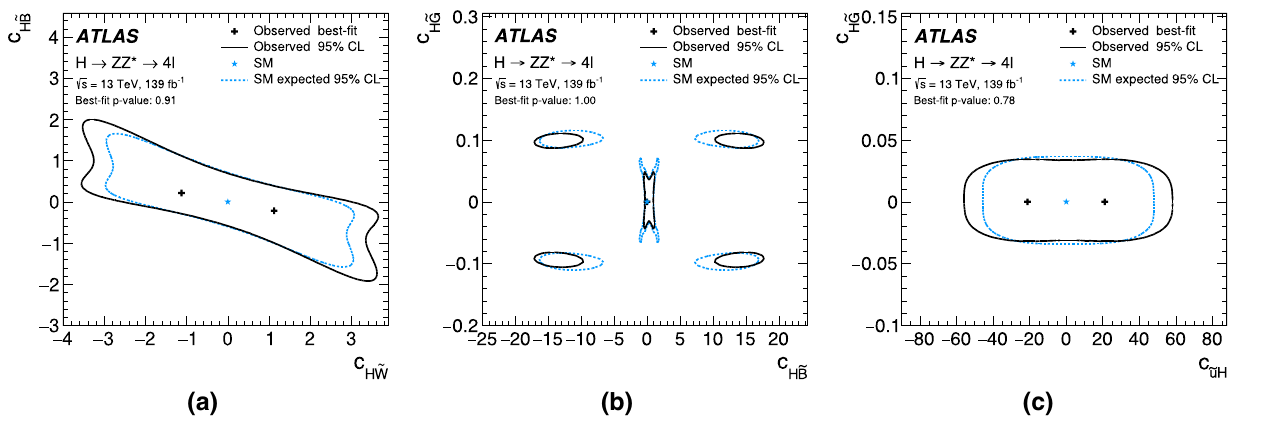
Fig. 18 Expected (dashed line) and observed (full line) 2D-fit likeli- hood curves at the 95% CL for the SMEFT Wilson coefficients of CP- oddoperatorsatanintegratedluminosityof139fb − 1 and